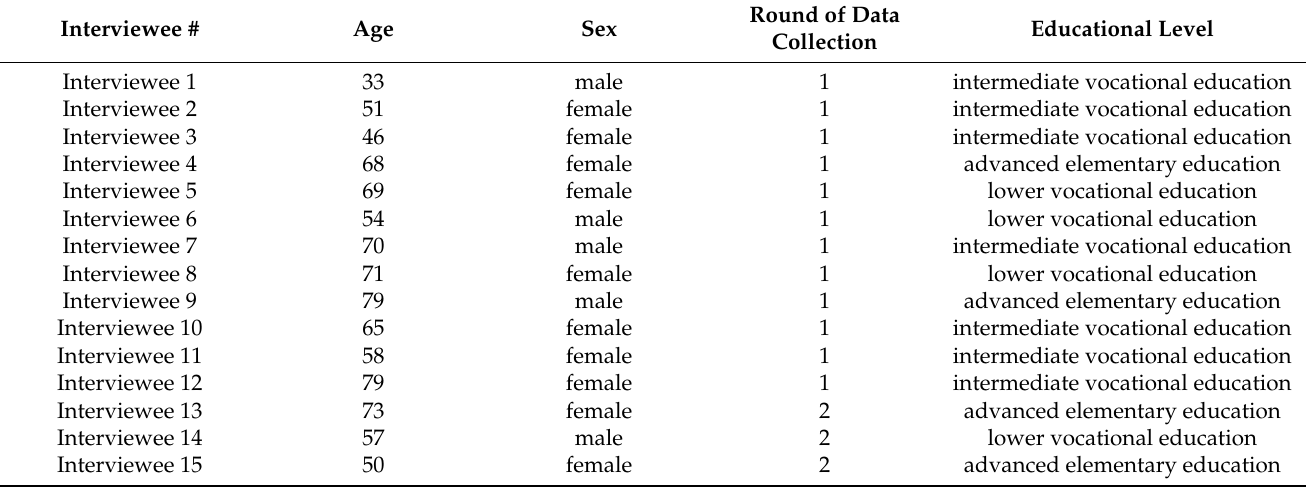
Table 1. Participant